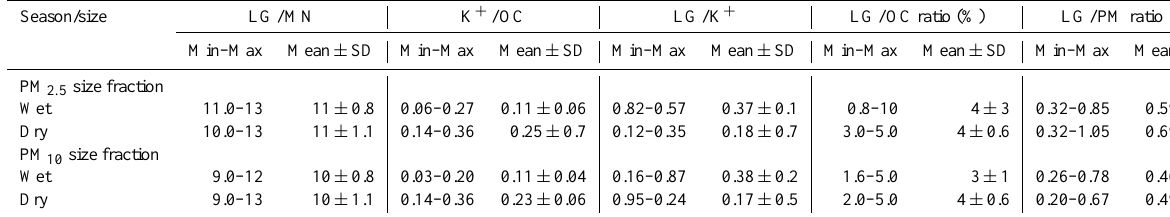
Table 2. Mean ratios and ranges of levoglucosan to mannosan (LG/MN), potassium to organic carbon (K + /OC), levoglucosan to potassium (LG/K + ) and levoglucosan to PM mass (LG/PM) in PM 2 . 5 and PM 10 during the wet and dry seasons. Season/size